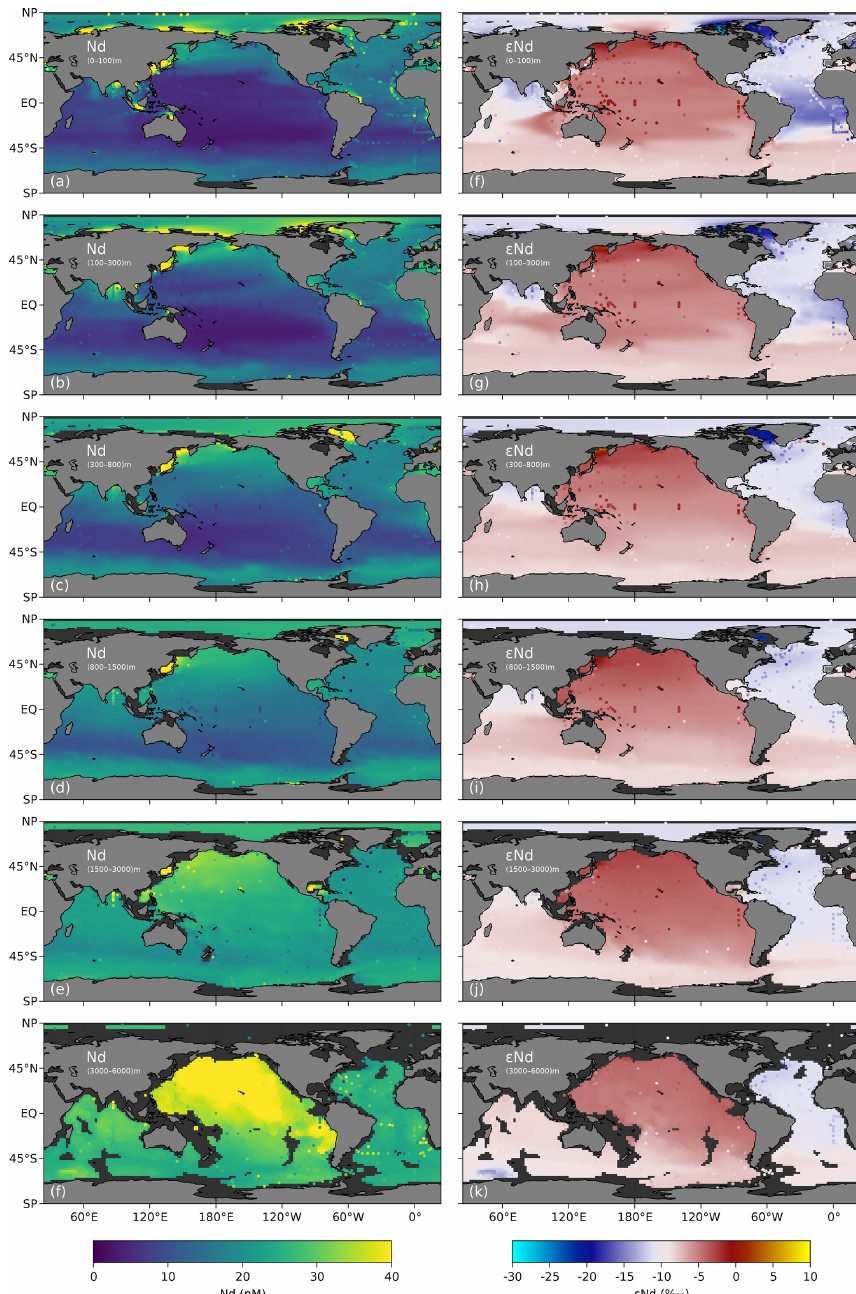
Figure 11. Model (heatmaps) and observations (markers) for (a–f) Nd concentrations and (g–k) ε Nd values. Model values are averaged over the indicated depth range. Individual observed values are overlaid on top of the modeled heatmap and on top of each other, so that perfect model–observation matches and deeper observations can be hard to see or